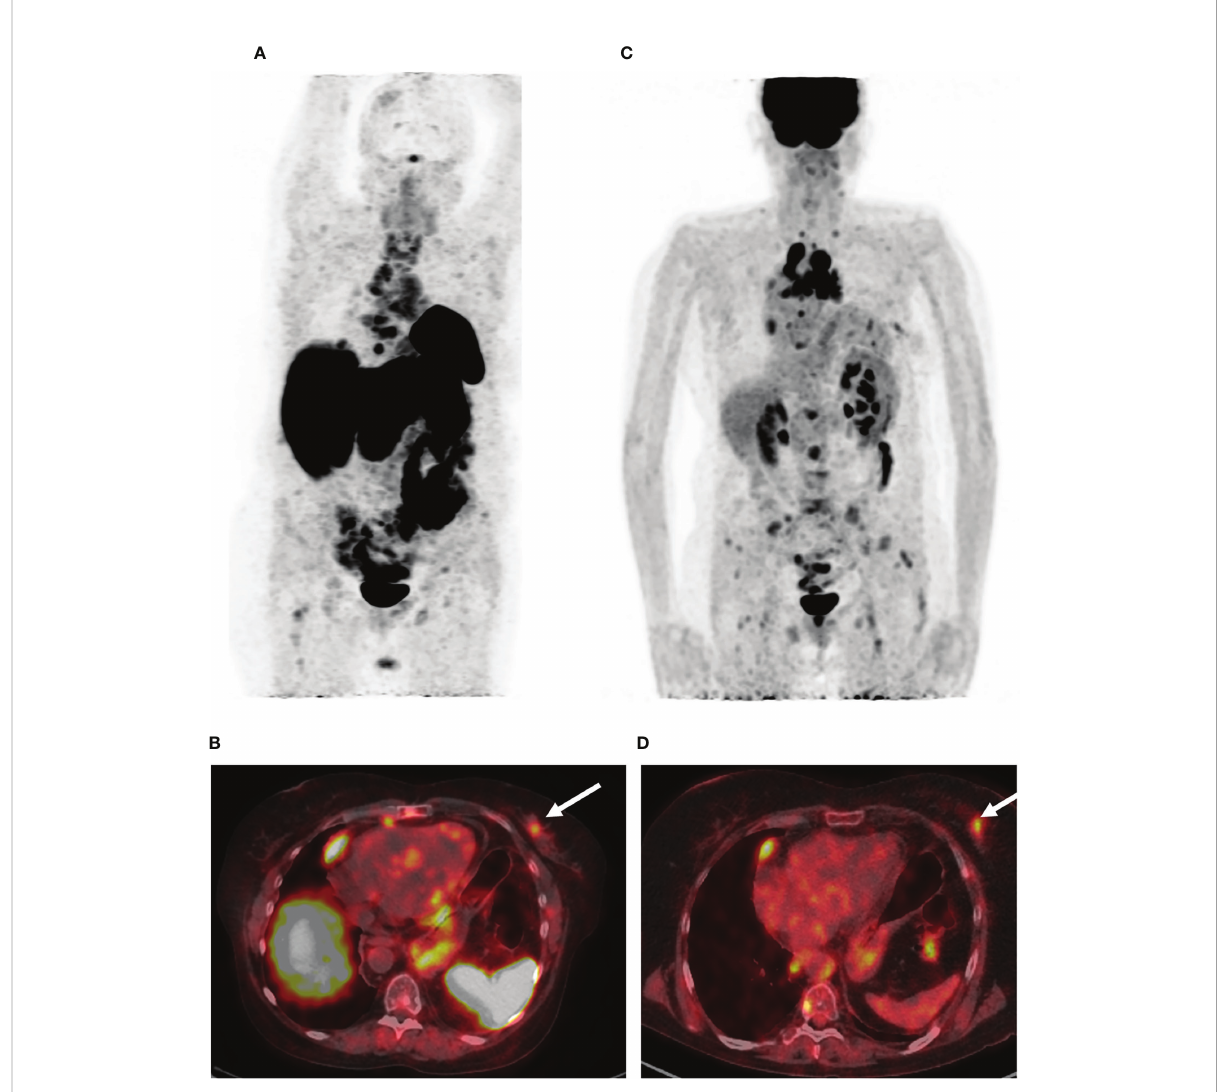
FIGURE 3 PET/CT images with [68Ga]-DOTA-TATE and [18F]-FDG. (A) The maximum intensity projection (MIP) images summarize the physiological and pathological distribution of [68Ga]-DOTA-TATE in the body. PET/CT scan showed an increase in the size of the previously detected metastases and the appearance of a new mediastinal lymph node and bone metastases. (B) [68Ga]-DOTA-TATE. PET/CT revealed an avid metastatic lesion in the upper inner quadrant of the left breast (white arrow). (C) The MIP images of [18F]-FDG PET showed intense tracer uptake in the same area as the [68Ga]-DOTA-TATE PET/CT scan. (D) [18F]-FDG-positive metastatic lesion in the left breast (white